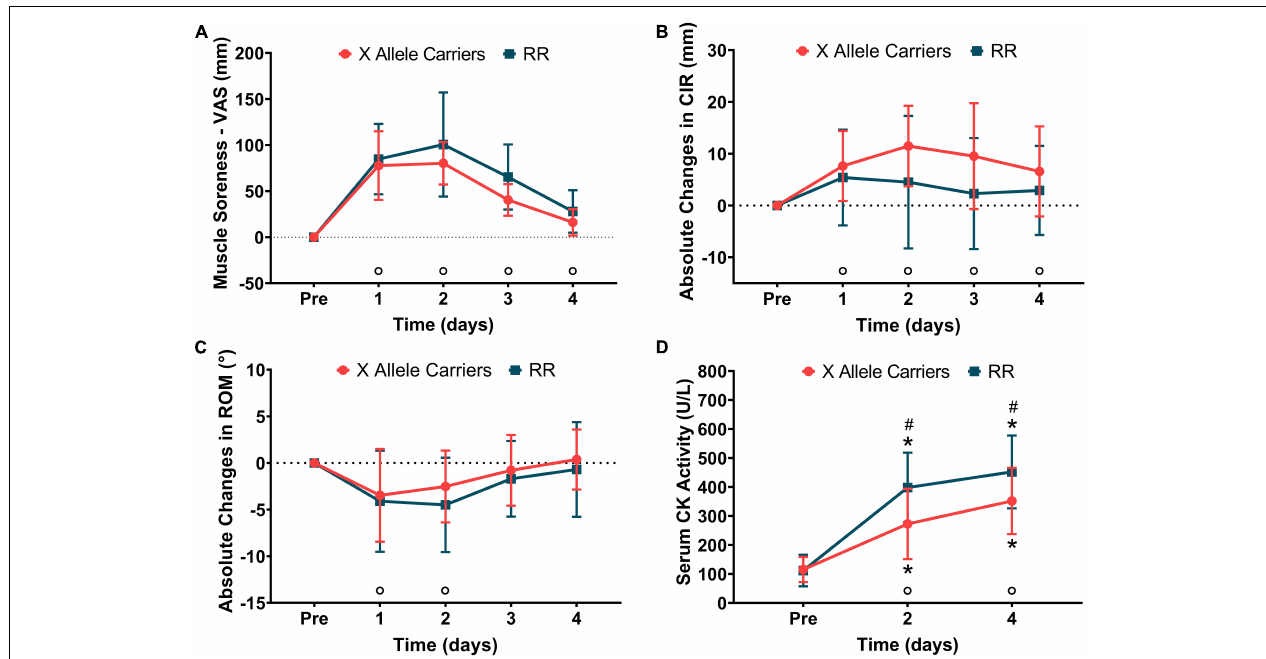
FIGURE 2 | The changes in muscle soreness (A) , mid-thigh circumference (CIR– B ), knee joint range of motion (ROM– C ), and serum creatine kinase (CK) activity (D) following downhill running for the RR and X allele carrying groups. ◦ P < 0.05 compared with pre for both the groups together; * P < 0.05 compared with pre for the same group; # P < 0.05 compared with RR at the same time